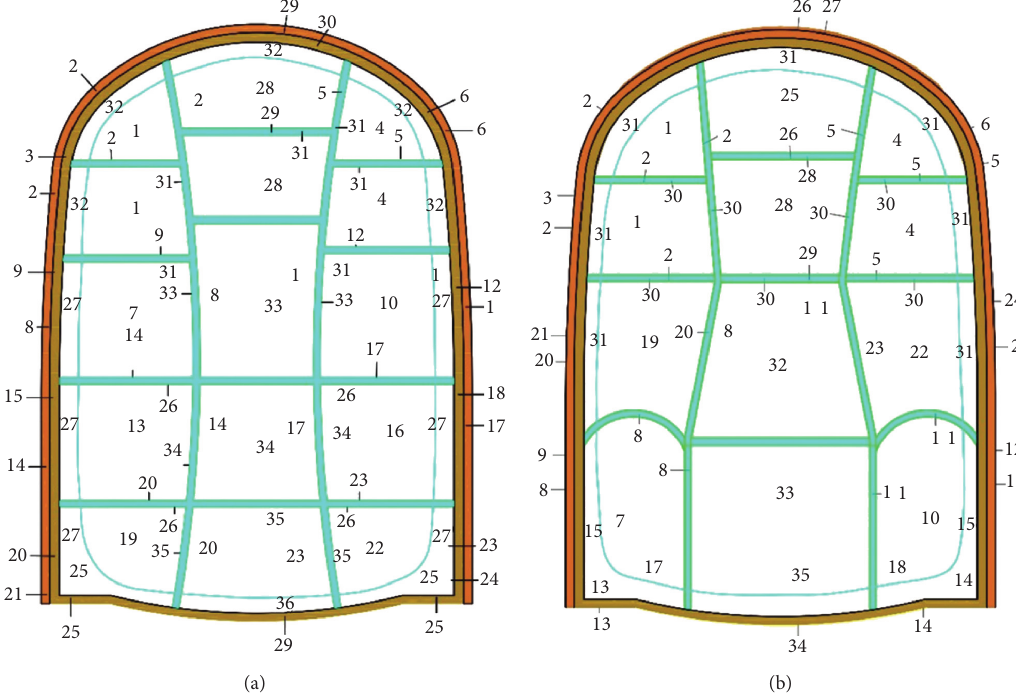
Figure 3: Excavation process of super-large section tunnel: (a) process of the double-side-wall heading excavation method; (b) process of the cross rock beam +heading